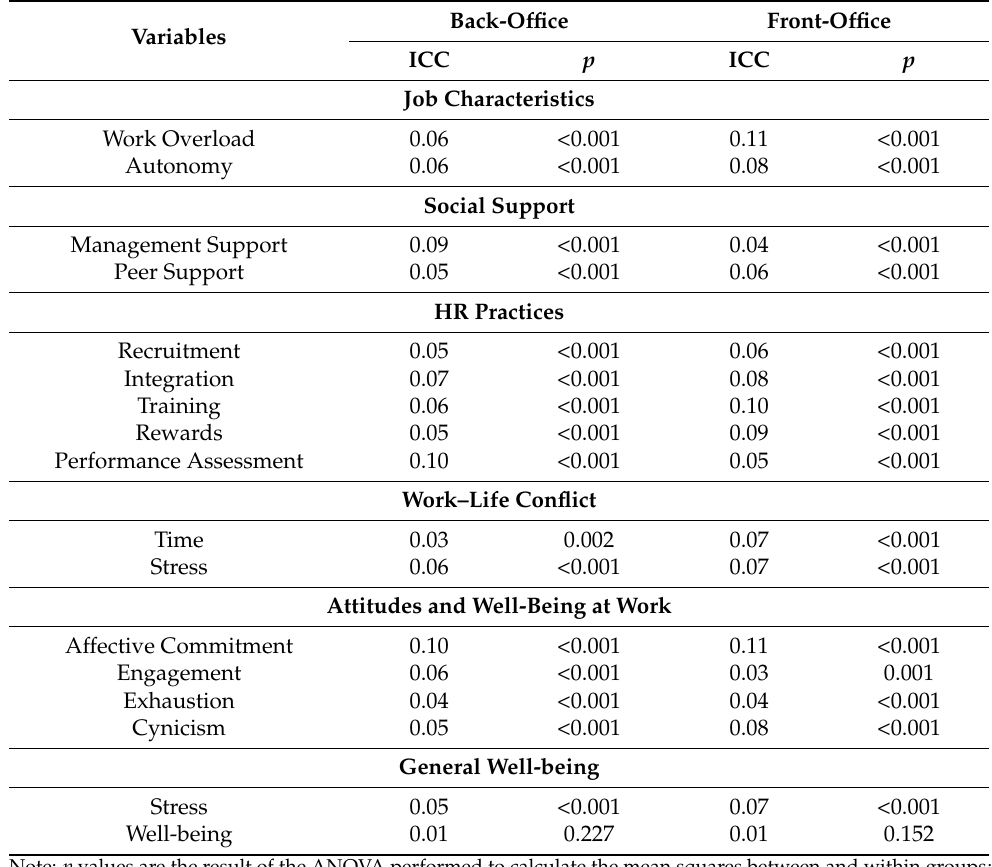
Table 3. Intra-class correlation coefficient of the variables under study, by occupation.